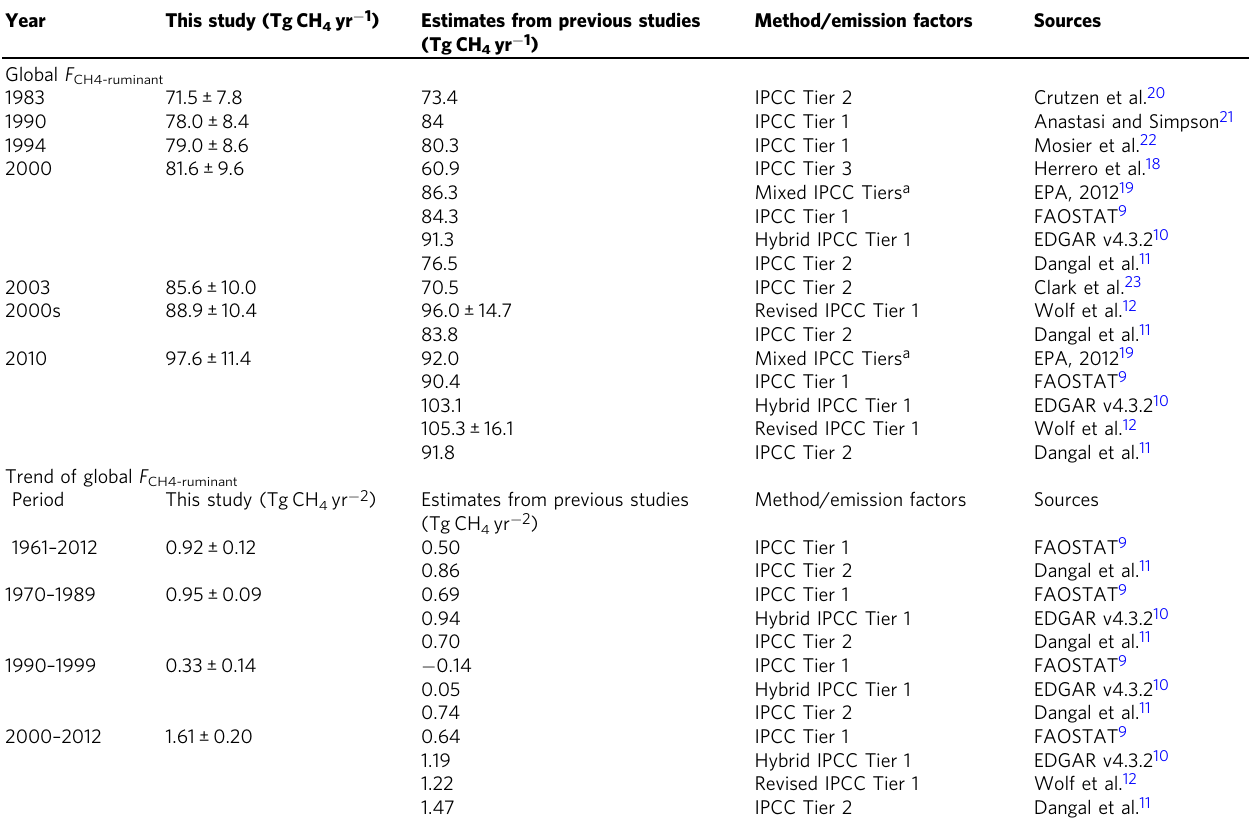
Table 2 Comparison of the global methane emissions from enteric fermentation of ruminants ( F CH4-ruminant ) and its trend Year This study (Tg CH 4 yr − 1